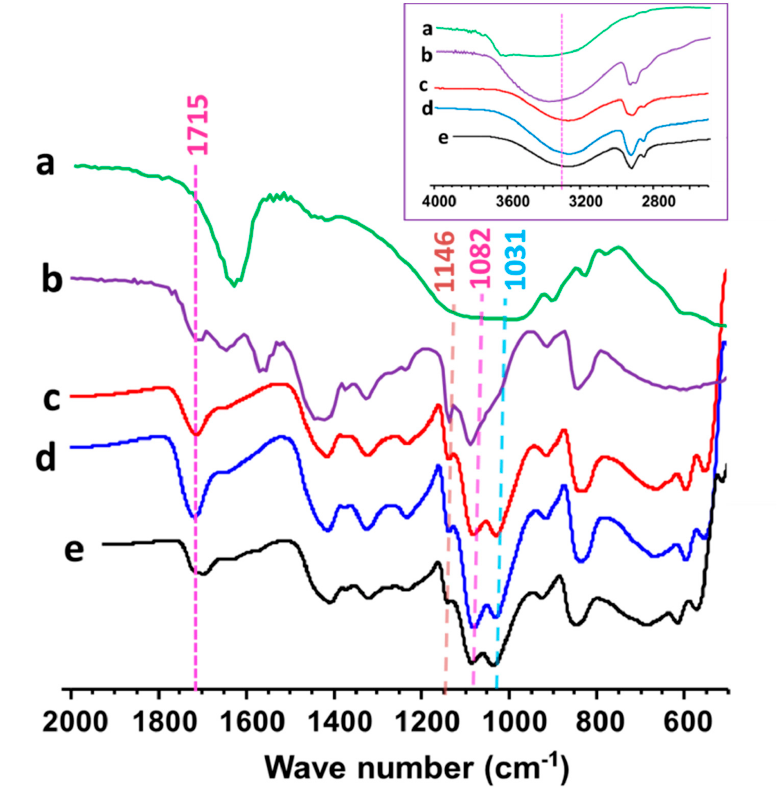
− 1 for ( a ) neat bentonite nanoclay, ( b ) neat PVA film, Figure 3. FTIR spectra in the range of 500–2000 cm − 1 for (a) neat bentonite nanoclay, (b) neat PVA film, Figure 3. FTIR spectra in the range of 500–2000 cm ( c ) PVA-15 crosslinked at 135 ◦ C -15 min, ( d ) PVA-15 crosslinked at 135 ◦ C -45 min, and ( e ) PVA-15 crosslinked at 150 ◦ C -15 min. The inset image represents the FTIR spectral features in the range of 2600–4000 cm − 1